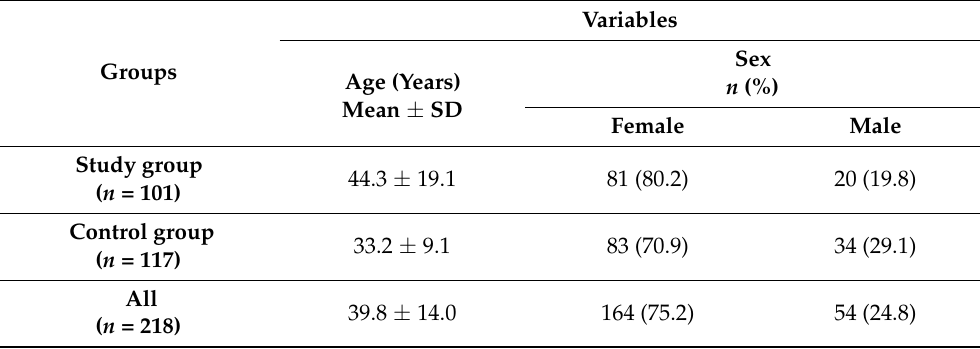
Table 3. The demographic characteristic of the study and control